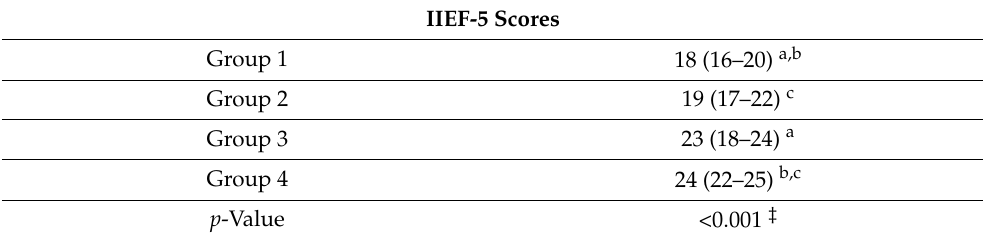
Table 2. Comparison of the study groups in terms of the IIEF-5